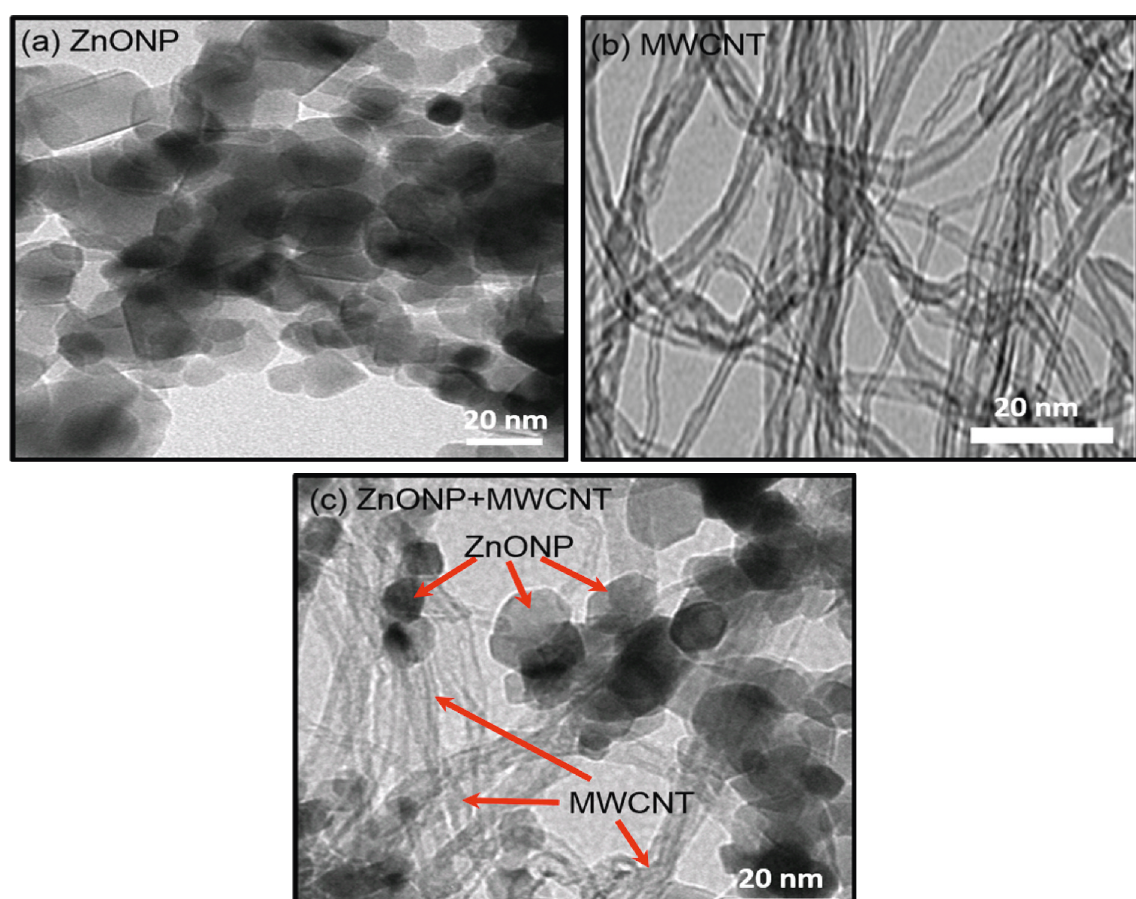
Figure 3: TEM images of (a) ZnONP, (b) MWCNT, and (c) ZnONP+MWCNT